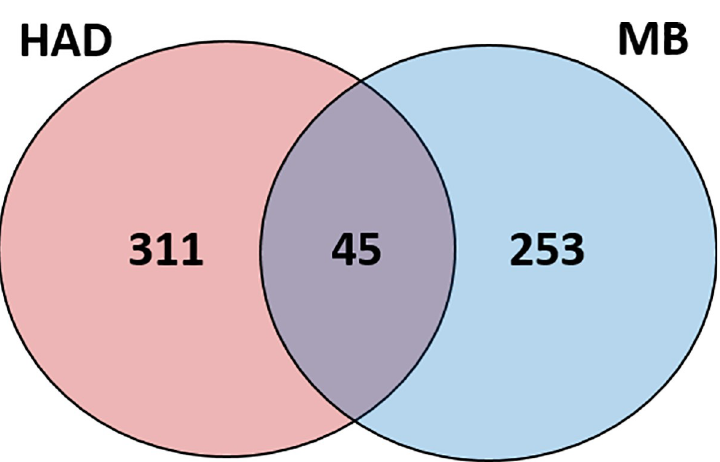
Fig 3. Venn diagram of acquired pellicle proteins identified in each study group and across groups. MB: metallic bracket, HAD: HA discs.